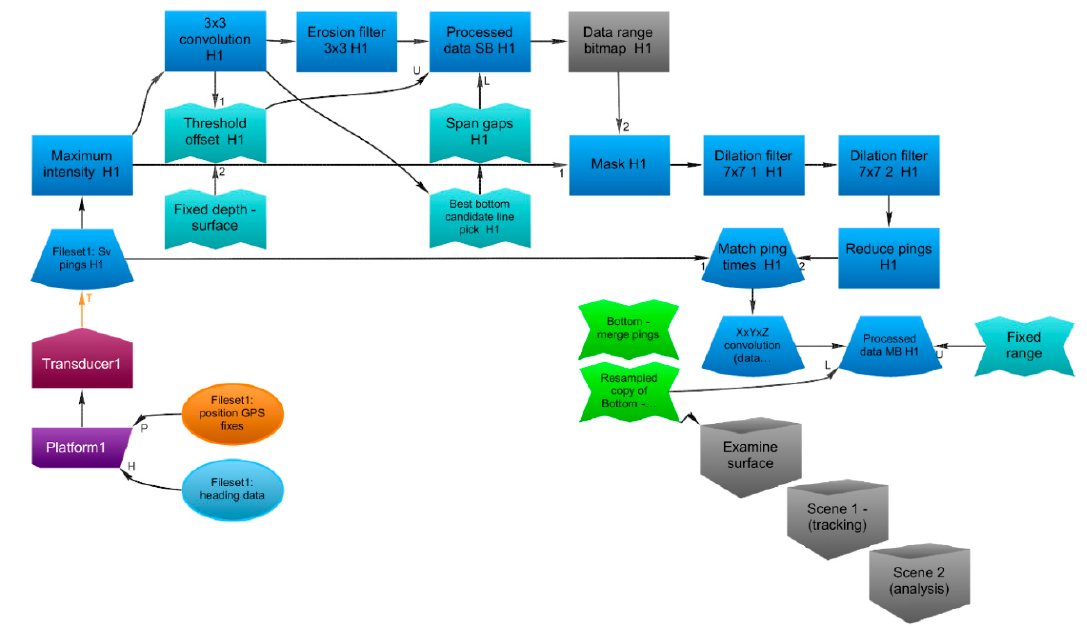
Figure 5. Echoview screenshot of the “Dataflow” window showing the data-processing steps applied to transducer 1 (“H1”). The same steps were applied to transducer 2.